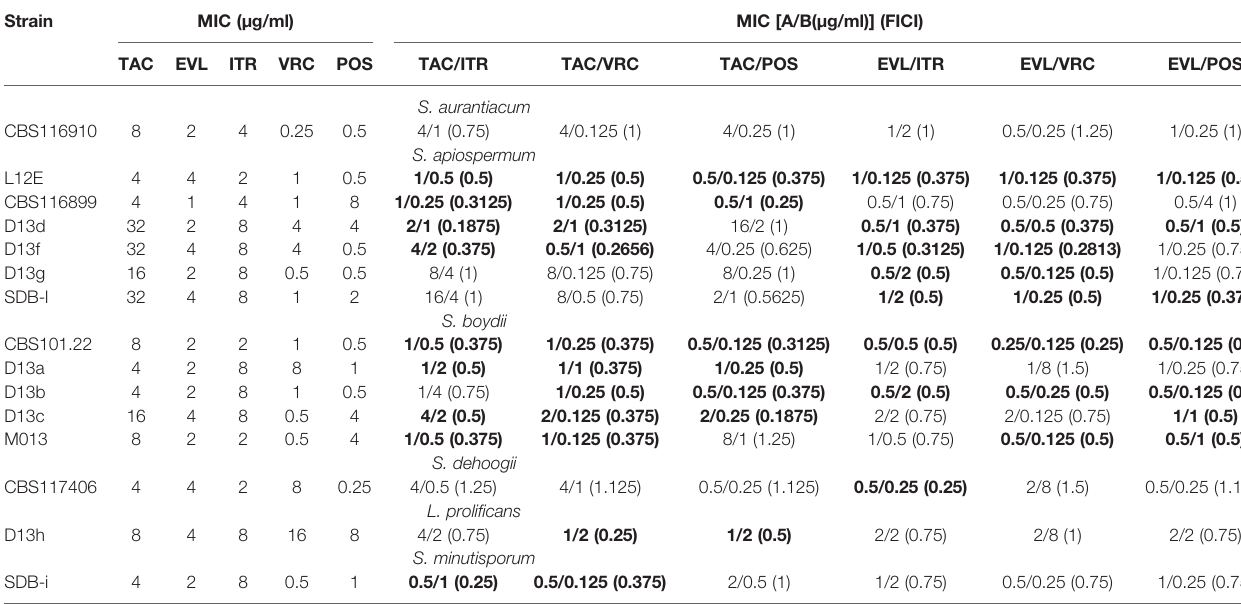
TABLE 1 | MIC and FICIs results of tacrolimus and everolimus in combination with azoles. Strain MIC (µg/ml) MIC [A/B(µg/ml)] (FICI) TAC EVL ITR VRC